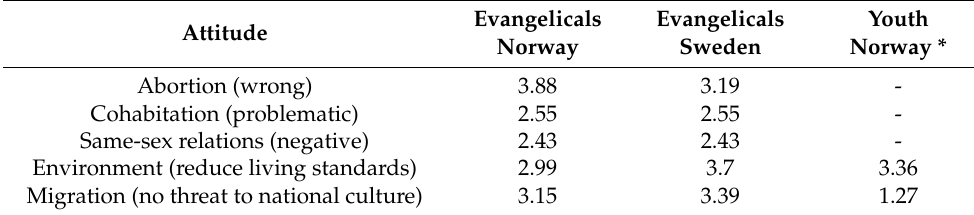
Evangelicals Evangelicals Youth Norway Sweden Norway *